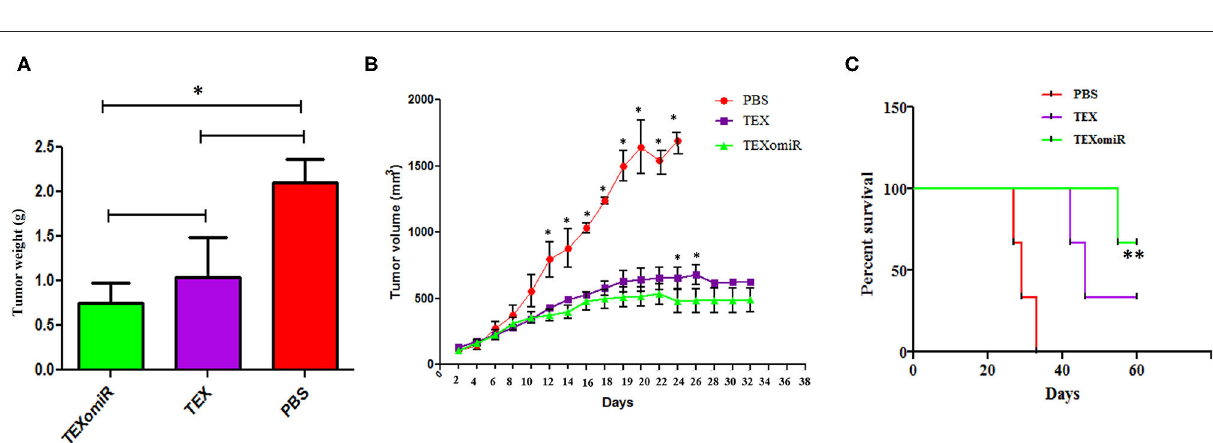
mice (ms = 46 days) or mice treated with PBS (ms = 29 days) ( P = 0.0051) ( Figure 6C